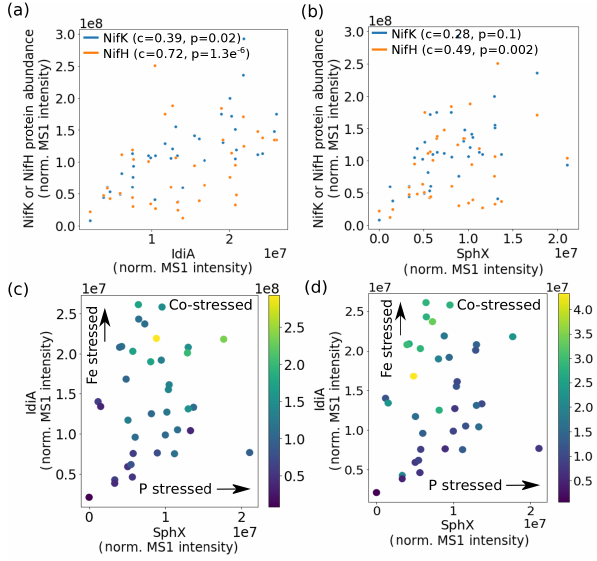
Figure 4. Nitrogenase abundance is highest at the intersection of high iron and phosphate stress. (a) IdiA and (b) SphX abundance is positively related to nitrogenase MoFe (NifK) and Fe (NifH) pro- tein abundance ( c represents the Spearman rank-order correlation coefficient and p represents the Spearman p value). Effects of com- bined iron and phosphate stress biomarkers on nitrogenase abun- dance. Marker colors represent abundance of NifK (c) and NifH (d) .